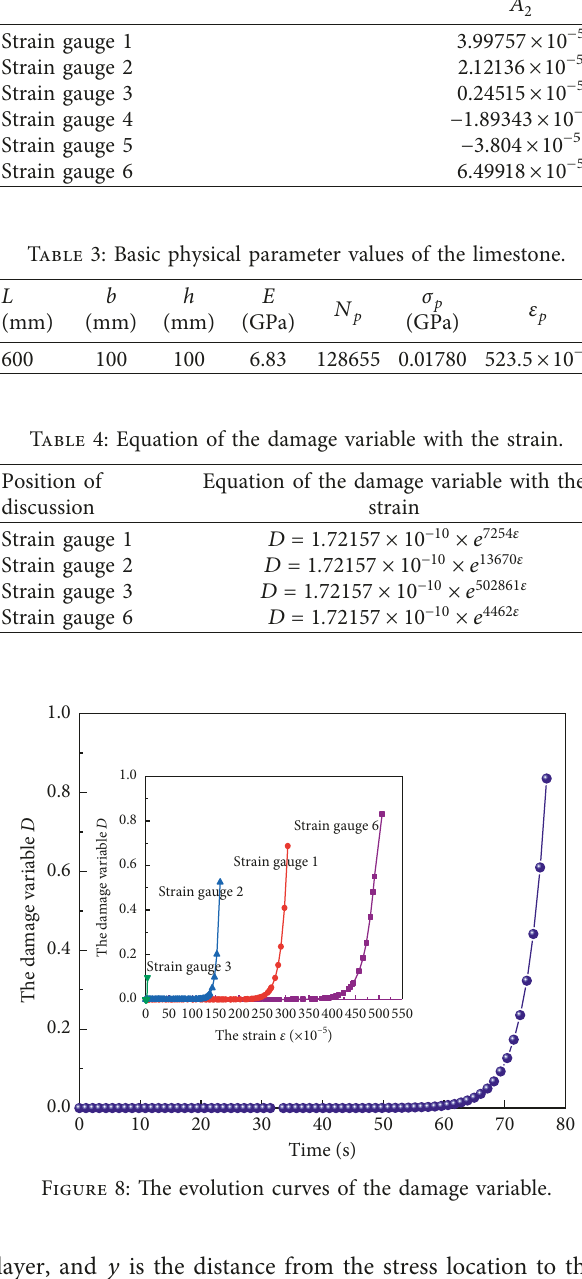
Table 2: Parameter fitting values of A